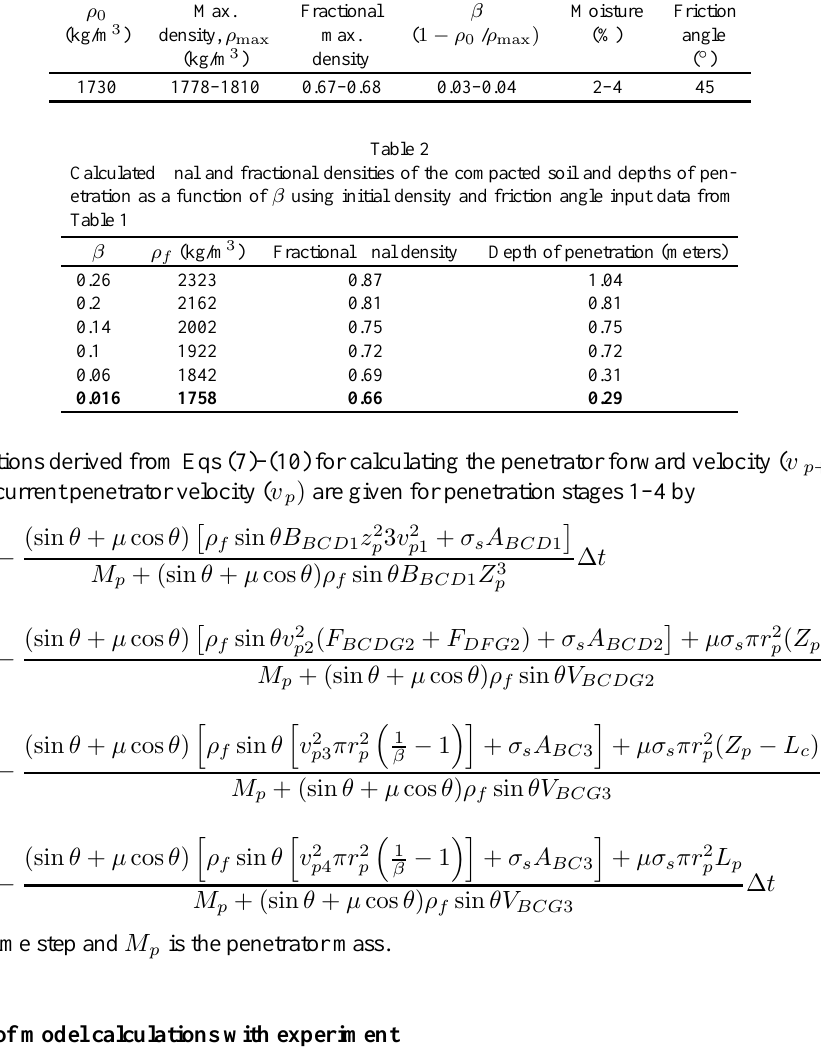
Table 1 Laboratory determined properties of target soil